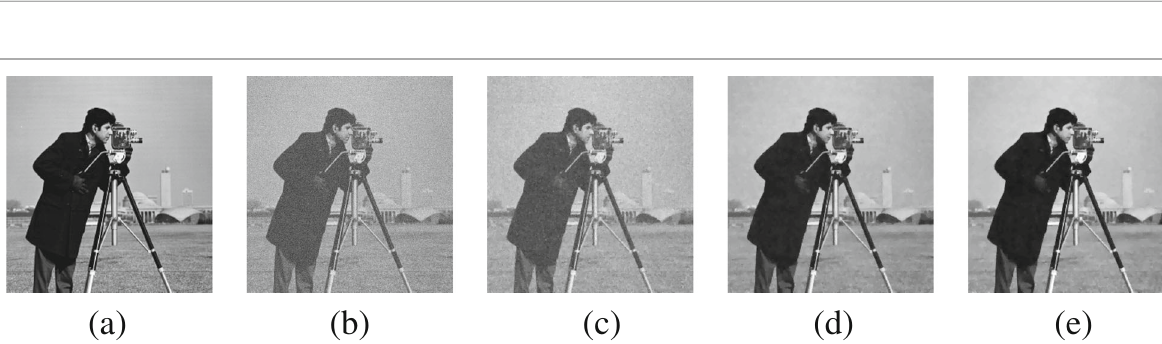
Fig. 5 Reconstructed results on SynImage2; a original image; b noisy image with additive Gaussian noise σ = 16; c restored image by method M1; d restored image by method M2; e restored image by method M3